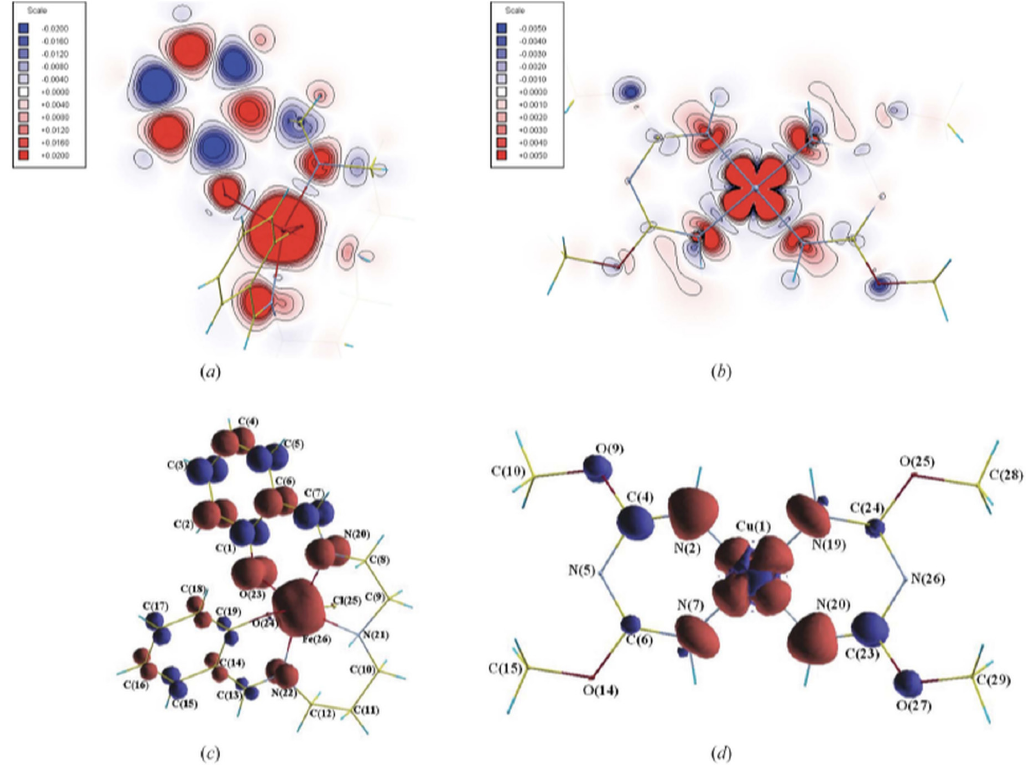
Figure 1. Two- and three-dimensional spin density plots obtained from X-ray restrained wavefunction calculations at UDKH2 (unrestricted second-order Douglas–Kroll–Hess) level for the iron and copper coordination compounds [Fe(salpet)Cl] ( a and c ) and [Cu L 2 ] ( b and d ). Reproduced with permission of the International Union of Crystallography from reference [63].